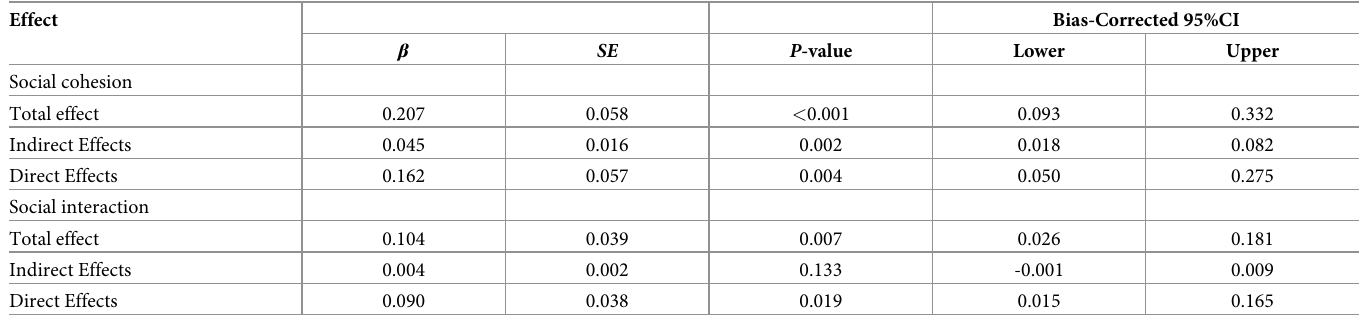
Table 4. The mediating effect of sleep duration on the relationship between SC and cognitive decline � .